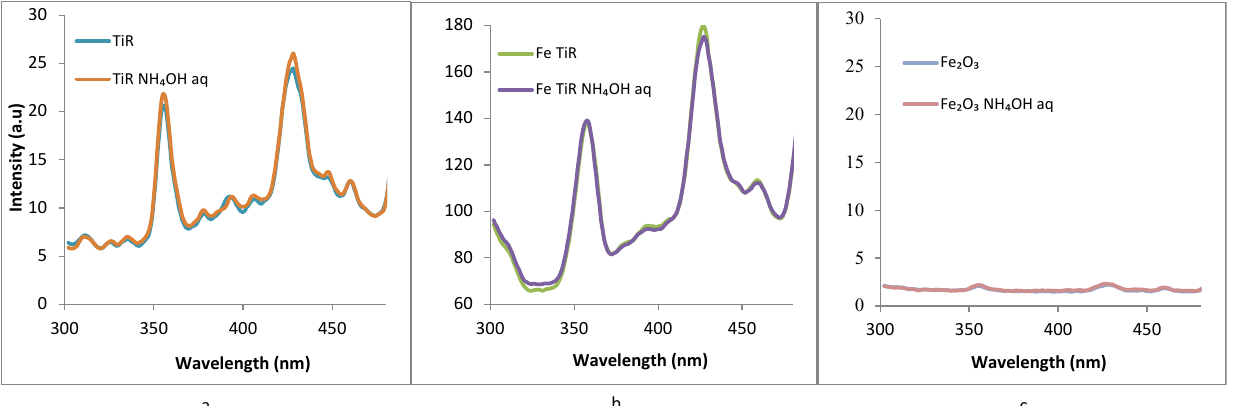
Figure 4. Room-temperature photoluminescence spectra of the powders suspended in water and diluted ammonia solutions, collected for λ exc = 260 nm: ( a ) TiR, ( b ) FeTiR, ( c ) Fe 2 O 3.